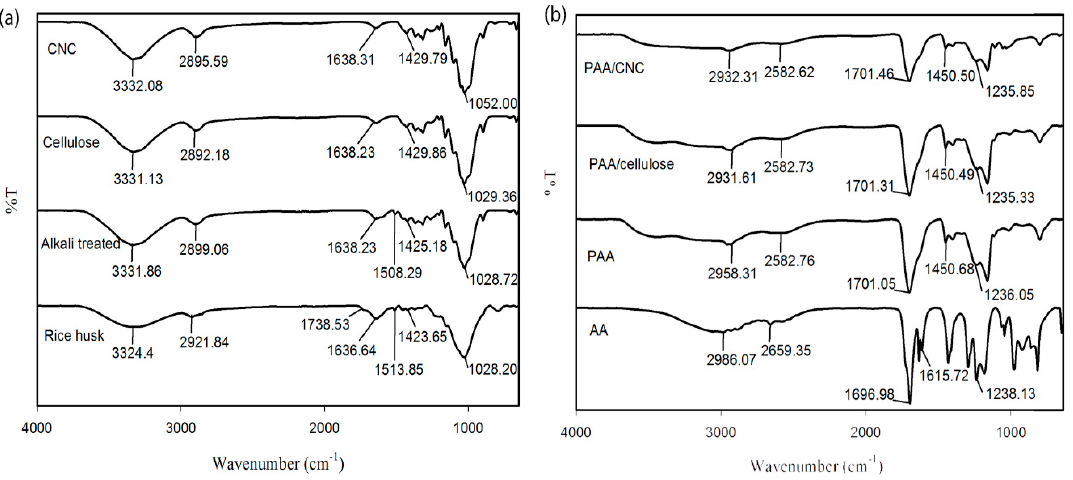
Figure 3. Fourier-transform infrared (FTIR) spectra of ( a ) raw rice husk fibers, alkali-treated rice husk fibers, cellulose, and CNCs; ( b ) monomer AA, pure poly(acrylic acid) (PAA) hydrogels, PAA/cellulose hydrogels, and PAA/CNC hydrogels.